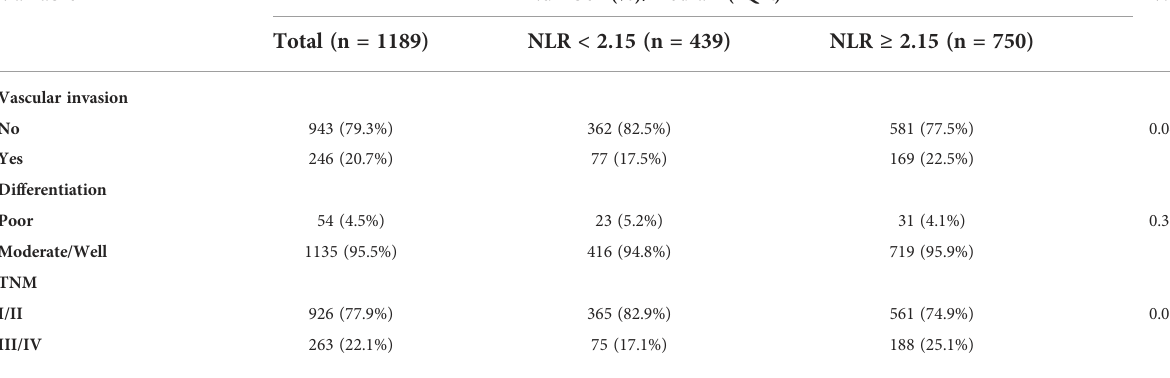
Supplemental Table 1. Multivariate analyses identi fi ed NLR